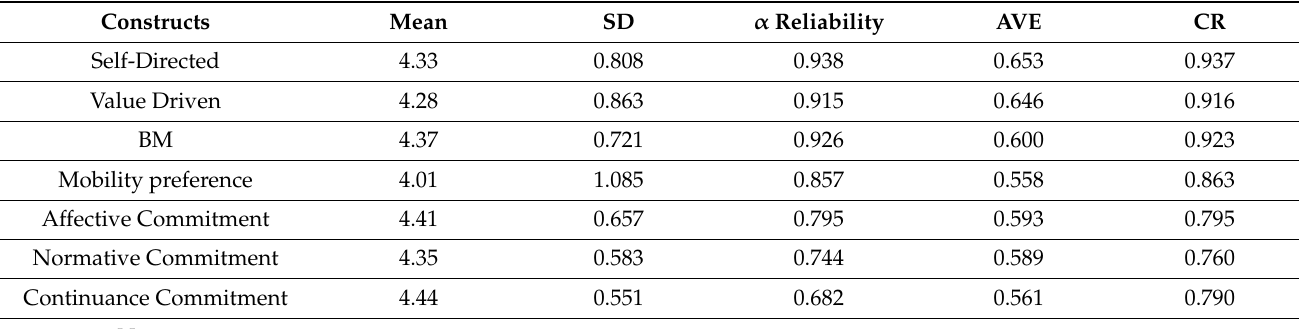
Table 5. Descriptive Statistics and